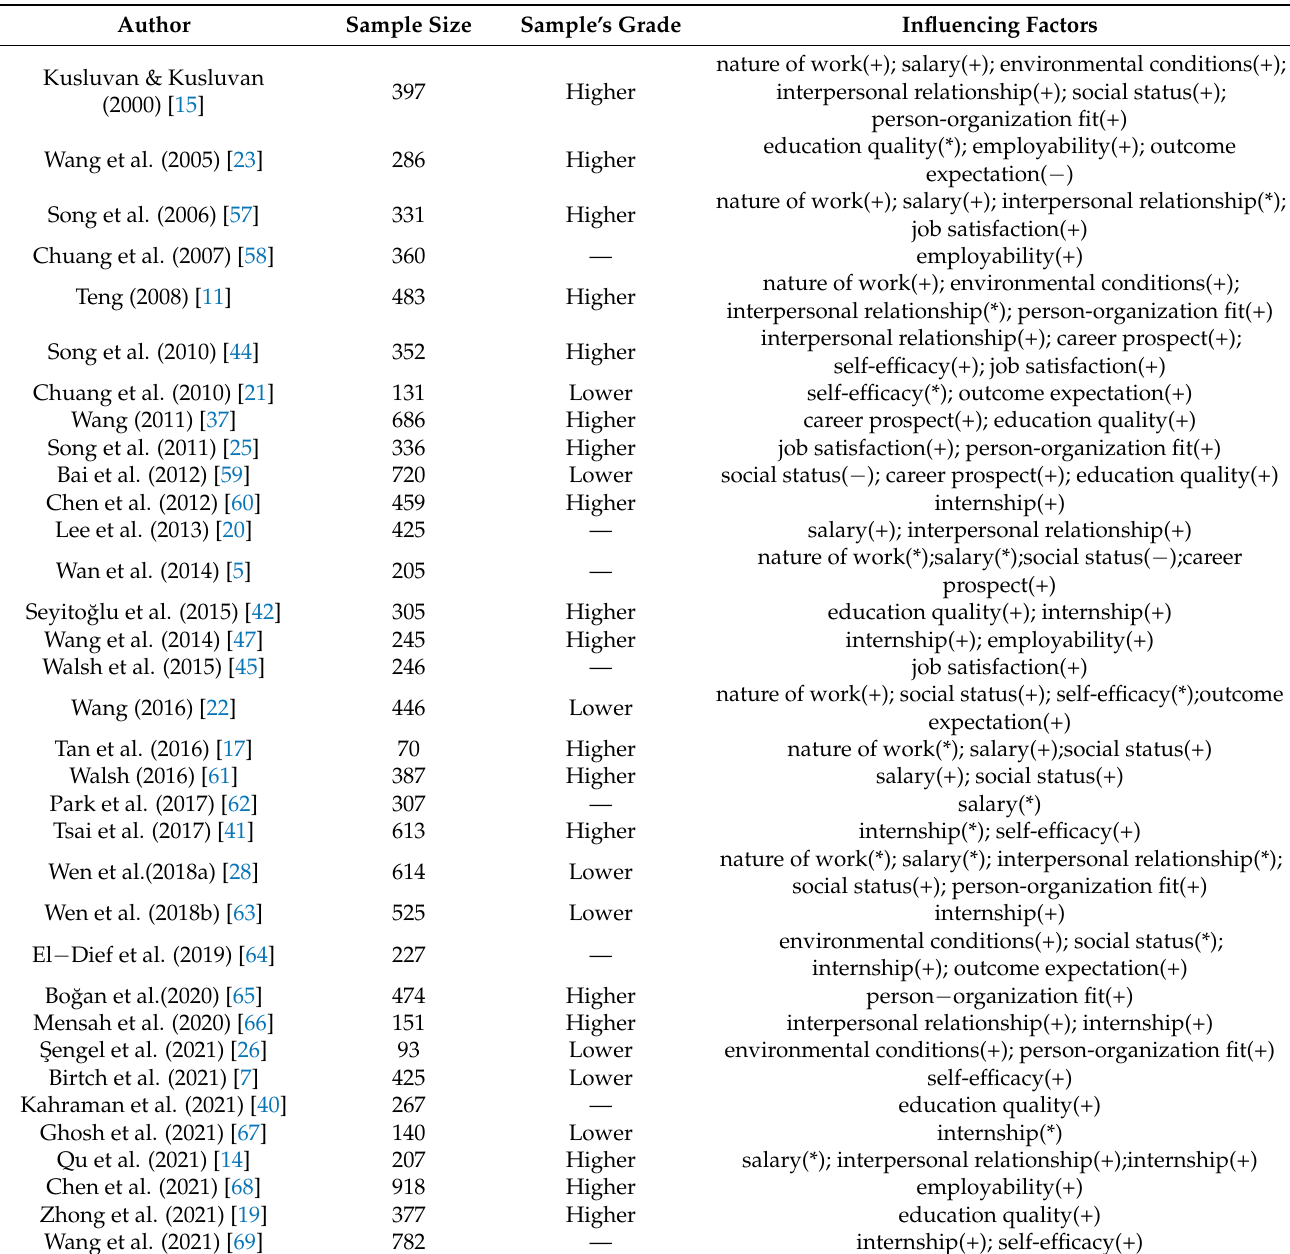
Table 1. Meta-analysis